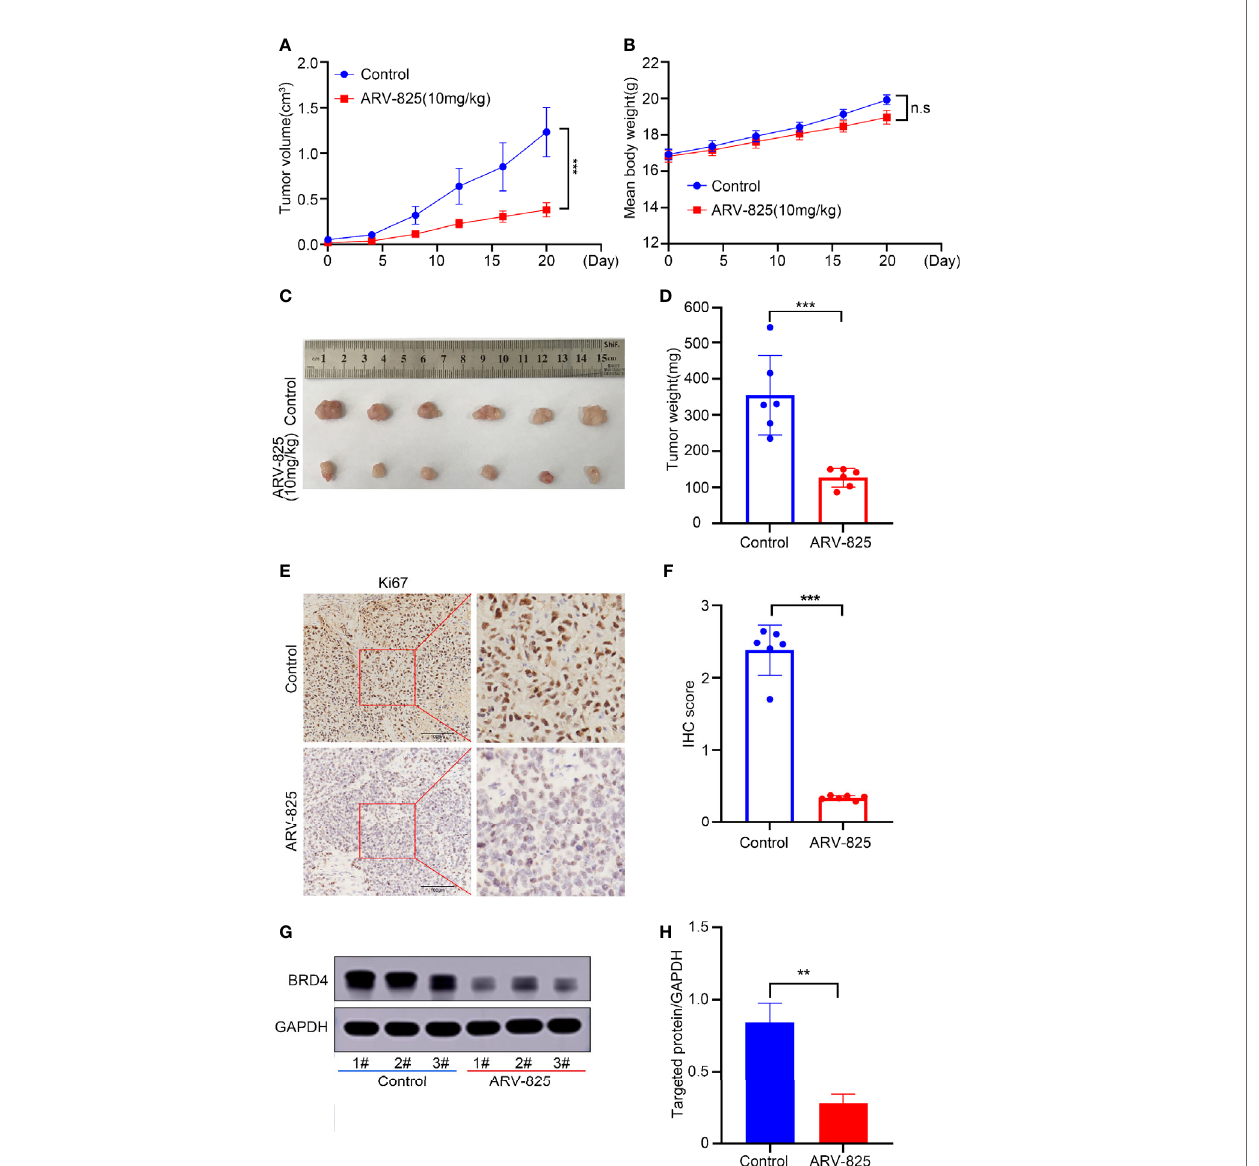
FIGURE 8 | ARV-825 suppresses tumor growth in the xenograft tumor model. Nude mice (n = 6) of HGC27 xenograft tumor were injected intraperitoneally by 10 mg/kg ARV-825 or menstruum control (10% Kolliphor ® HS15) daily for 20 days. (A) Changes in the tumor volume in mice treated with ARV-825 and menstruum control. (B) The weight of mice was monitored during the experiment. (C) Pictures of xenograft tumors from mice treated with ARV-825 and menstruum control. (D) Tumor weight from mice treated with ARV-825 and menstruum control. (E) Immunohistochemical staining of Ki67 from xenograft tumors. (F) Immunohistochemical scoring of Ki67 staining from xenograft tumors. The total scoring (TS) = the intensity (I) × percentage of positive cells (P). (G) BRD4 protein levels in xenograft tumors. (H) ARV-825 inhibited BRD4 protein levels from xenografted tumors. n.s, not signi fi cant, ** p < 0.01; *** p <